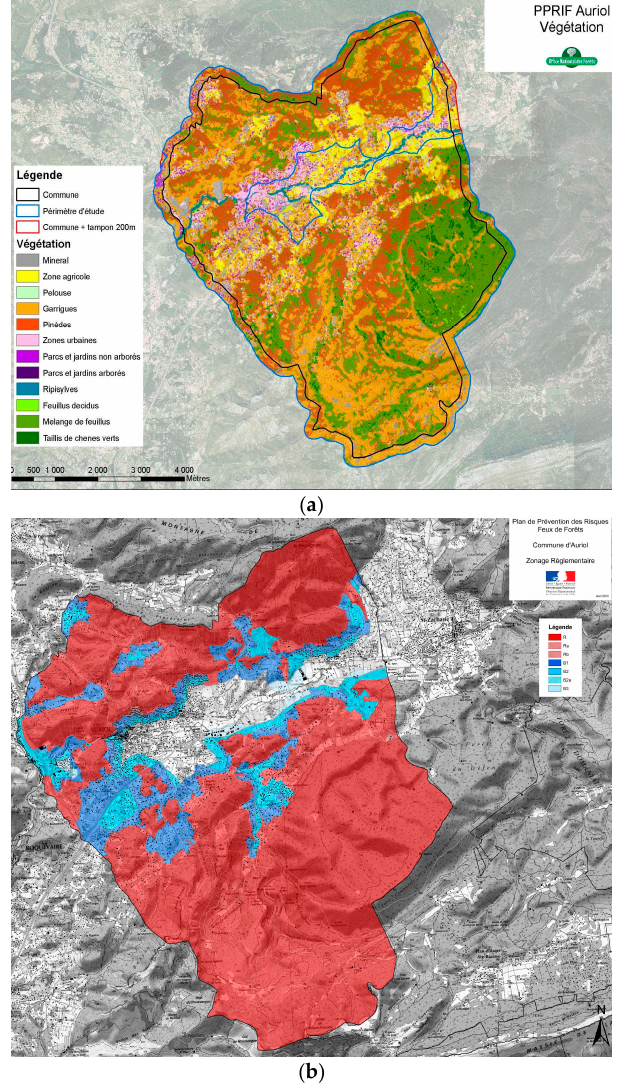
Figure 3. ( a ) Map from the Plan de Prévention des Risques d'Incendies des Forêts (PPRIF) for Auriol, France. The predominant vegetation types are shown, as well as the agricultural ( zone agricole ) and urban ( zones urbaines ) land use zones. ( b ) Overlay of wildfire hazard zoning developed in the Auriol PPRIF with Red, B1, B2, and B3 zones. No new construction is allowed in the Red Zone due to wildfire hazard. PPRIFs divide a jurisdiction into three planning zones (Figure